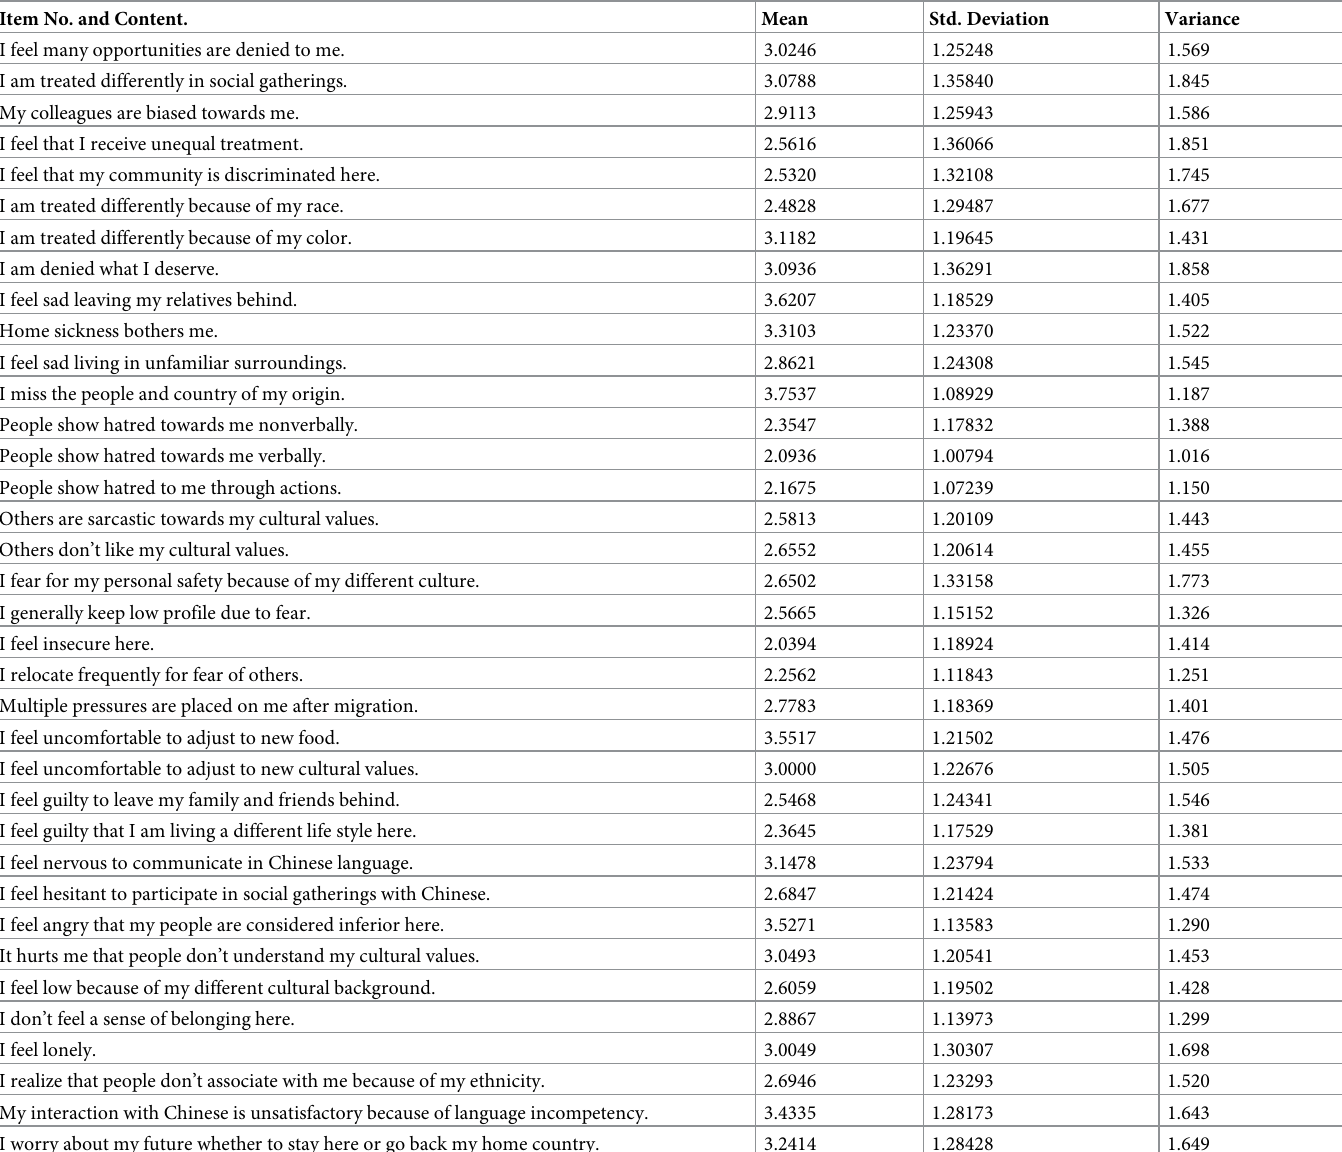
Table 7. ASSIS scale items with mean, std. deviation and variance. Item No. and